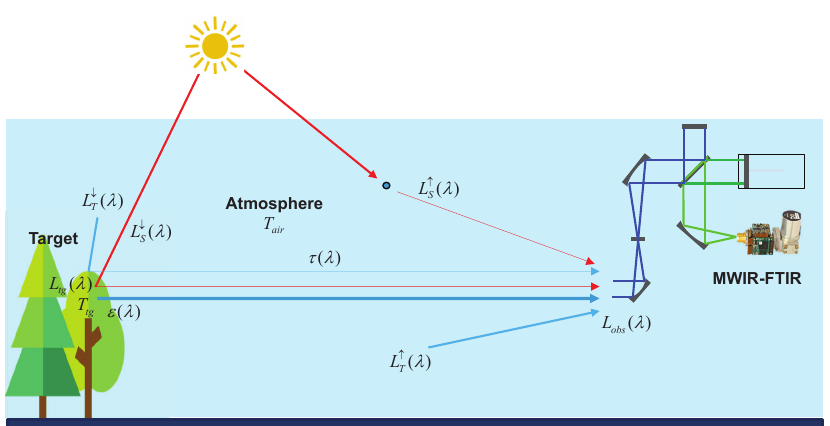
Figure 1. Operational concept of AT 2 ES using a passive open path Fourier transform infrared ( λ ) represent the spectral downwelling solar radiance and imaging system. Notation: L ↓ s ( λ ) and L ↓ t ( λ ) are spectral upwelling solar and thermal path thermal irradiance, respectively; L ↑ s ( λ ) and L ↑ t radiance, respectively, reaching the sensor.